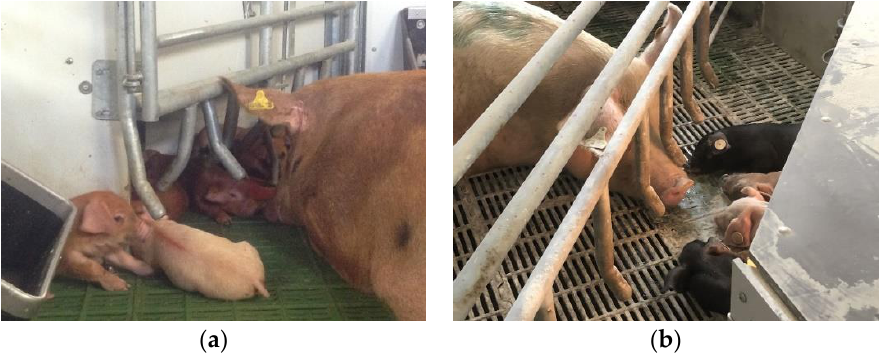
Figure 3. Different distances for the sow to access the creep area in ( a ) SWAP and ( b ) JLF15 pens.